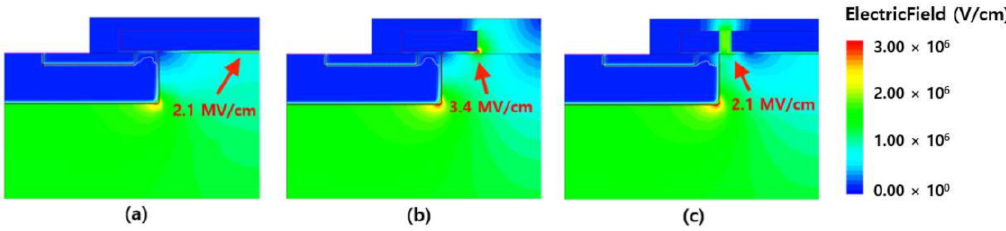
Figure 11. Electric field distribution of ( a ) C-DMOSFET (conventional planar DMOSFET); ( b ) SG-DMOSFET (split-gate DMOSFET); and ( c ) FPS-DMOSFET (floating p+ polysilicon DMOSFET) in the off state (V DS = 3000 V, V GS = 0